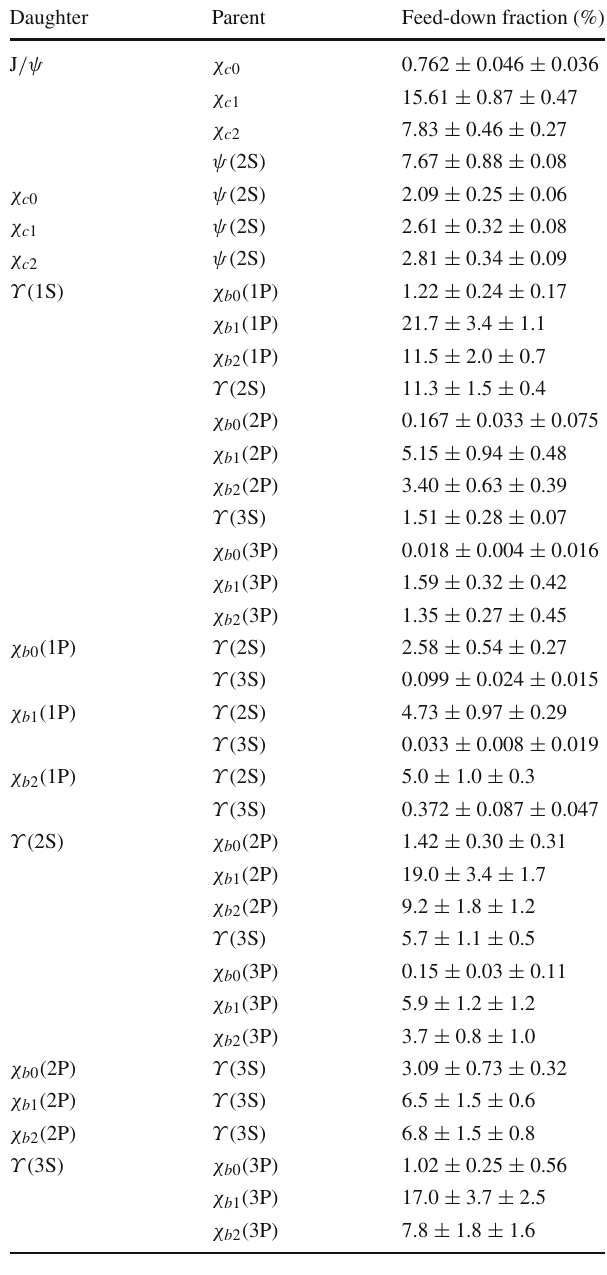
Table 1 Feed-down fractions between the several quarkonia, for p T / M > 2. The first uncertainty reflects the precision of our fit, while the second reflects the branching fractions Daughter